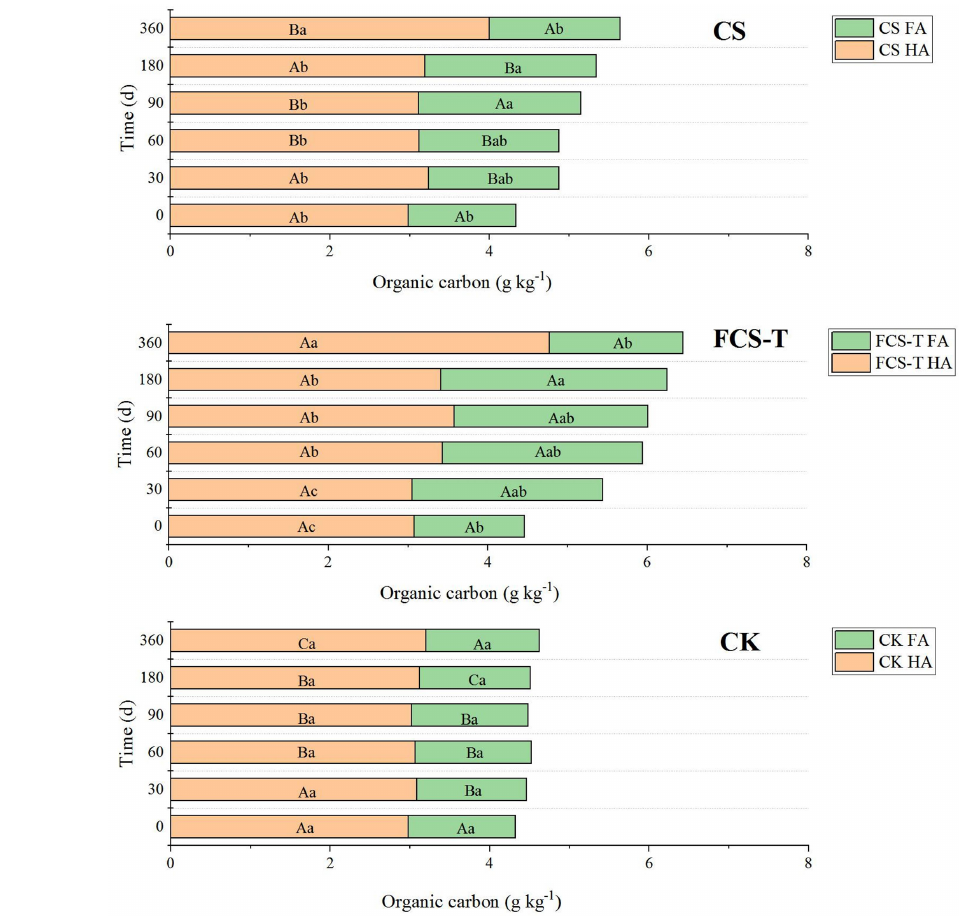
Figure 5. The carbon contents of humic acid (HA) and fulvic (FA) isolated from different treatments. Each bar represents the mean of HA and FA in the figure ( n = 3). Different uppercase letters mean significant difference ( P < 0 . 05) for either HA or FA among the treatments in a particular time (d) of the experiment. Different lowercase letters mean significant difference ( P < 0 . 05) for either HA or FA among different experimental times (d) for a given